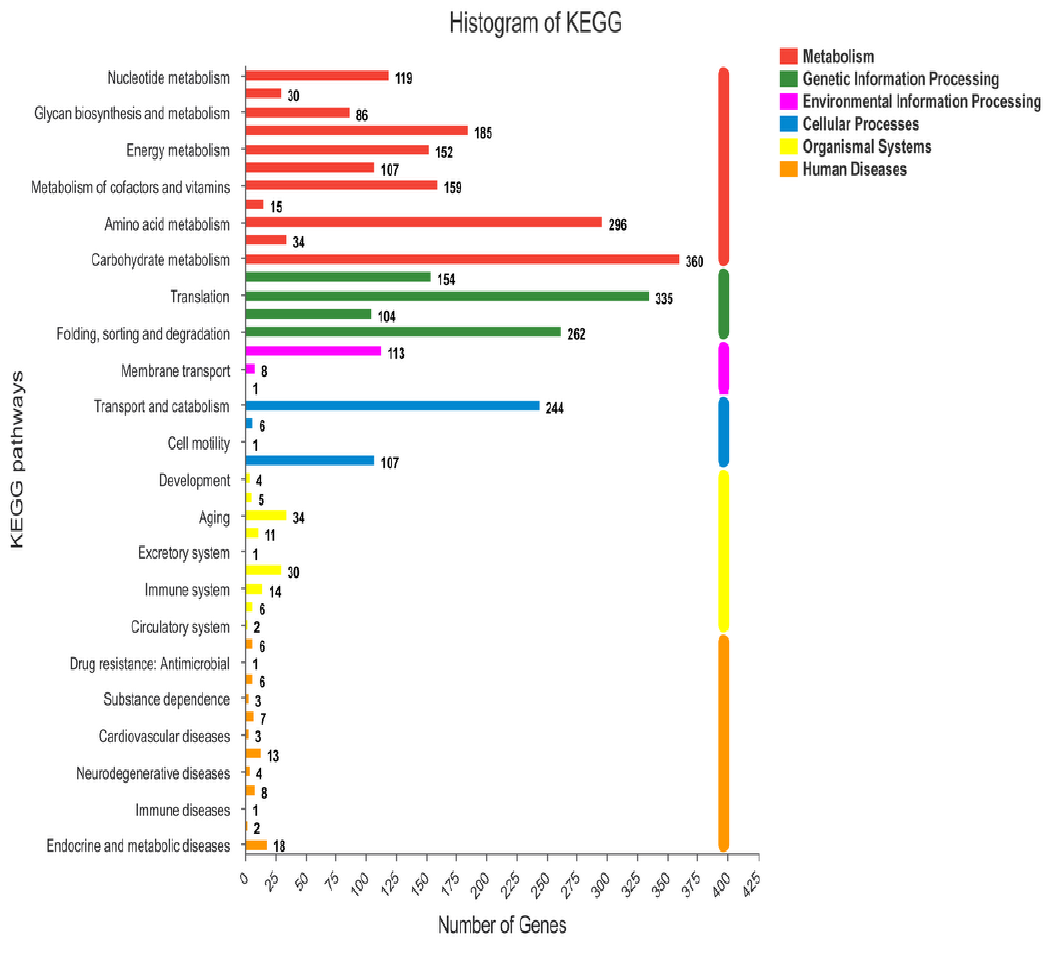
Figure 4. Histogram of KEGG pathways.